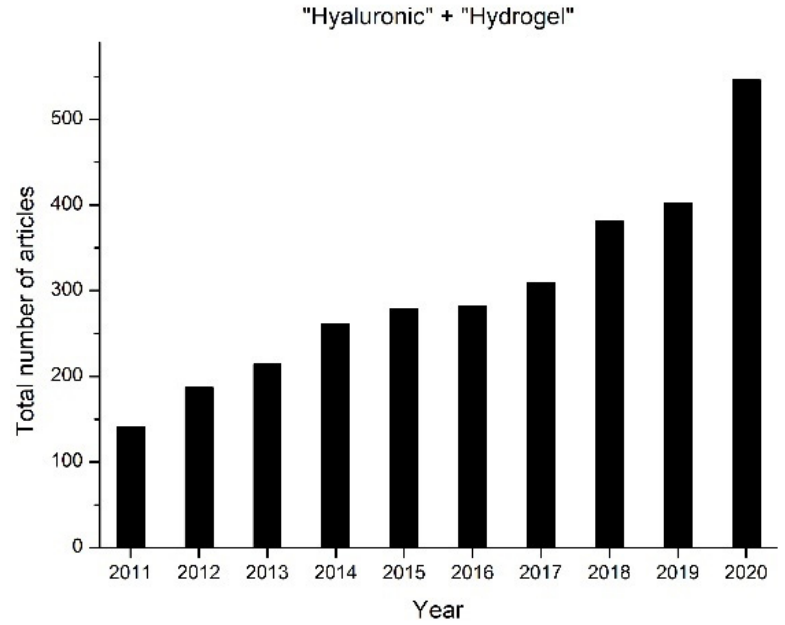
Figure 1. Number of papers that contain the terms ‘Hyaluronic’ and ‘Hydrogel’ (2011–2020) (Source: SCOPUS).